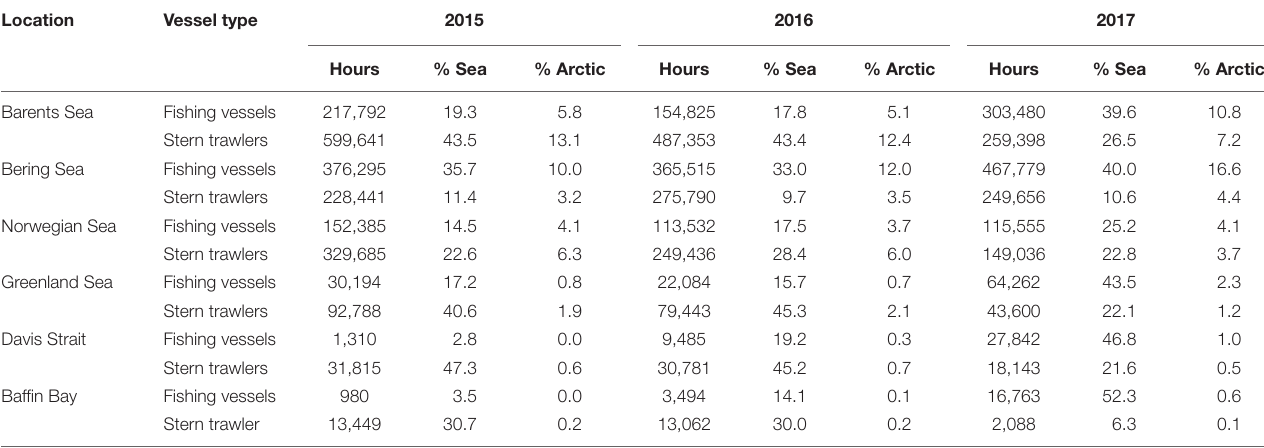
TABLE 3 | Hours of operation by fishing vessels in waterways in which commercial fisheries operations were the predominant vessel activity (as measured by hours of operation). Location